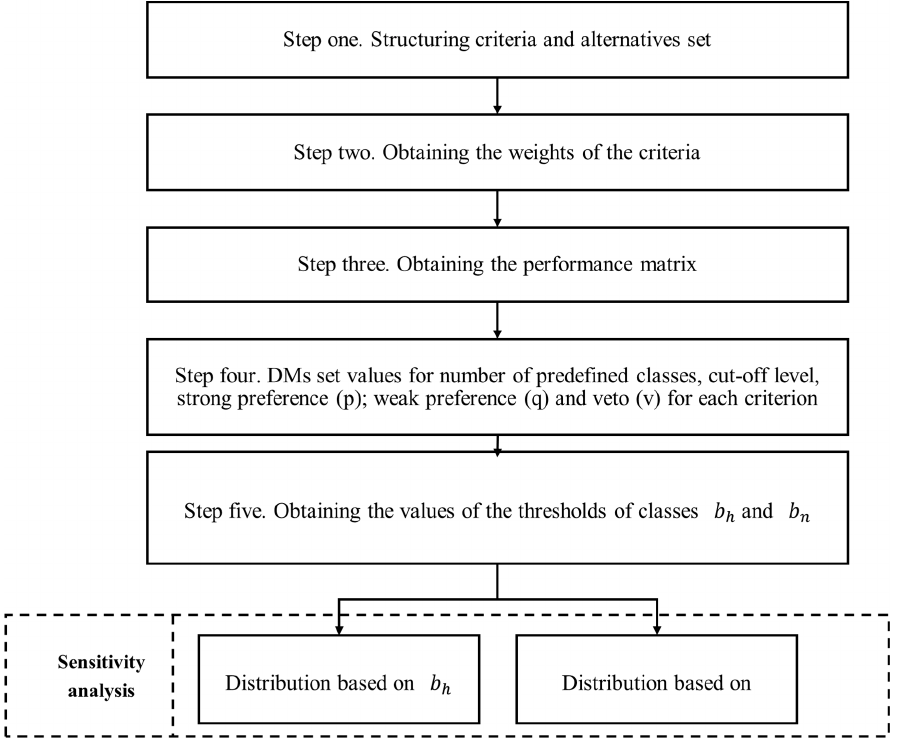
Figure 10. Steps of the applied